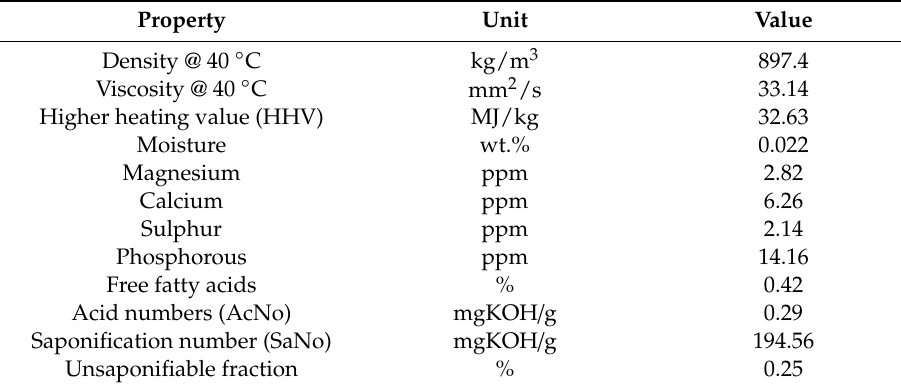
Table 4. Physiochemical properties of the